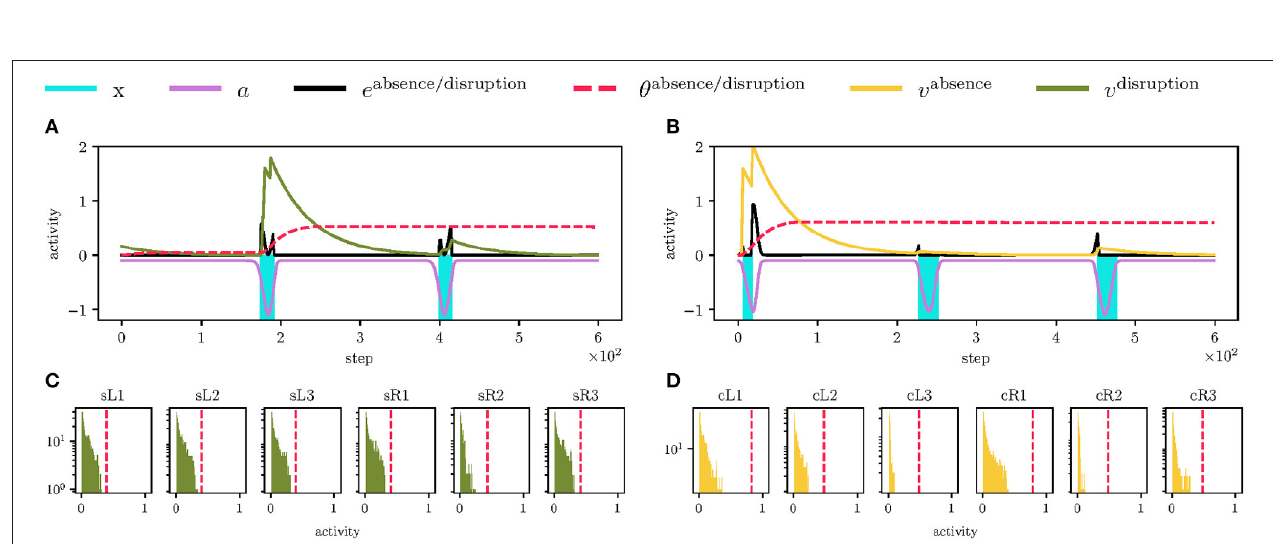
FIGURE 9 | Adaptation of the firing threshold θ . (A) Detail of the LIF threshold θ disruption (visualized as the red dashed line) adaptation for the left leg’s early swing stop. Initially, the threshold is set to zero, thus LIF fires (in the green) at the first non-zero error e disruption (in the black), where the error is rectified difference between the early stop event x (in the blue) and RBF anticipation a (in the magenta), h ( x − a ). During the LIF firing, the threshold rapidly grows; therefore, the next LIF non-zero activity at step 400 is below the threshold, and LIF does not fire. The threshold slowly decays (not observable in plots). (B) The LIF detector (in the yellow) for the left leg’s contact absence behaves similarly. The last thousand steps of the LIF neuron activations are aggregated in histograms, where it is shown that the respective thresholds are upper-bound of the regular activations. (C) The swing stop perception is precise during the regular motion; thus, the LIF activity (in the green) is similar for all legs, and so are the thresholds (showed as the red dashed line). (D) However, the ground contact perception differs for each leg (probably due to different loads on the legs during the stance) and is less precise (the leg sometimes did not detect the ground contact). It resulted in the increased variance of the ground contact absence thresholds across the legs. Note that the contra-lateral legs (e.g., cL1 and cR1) have similar thresholds.